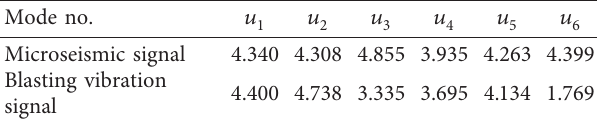
Table 1: Multiscale singular spectrum entropy of the two signals. Mode no.